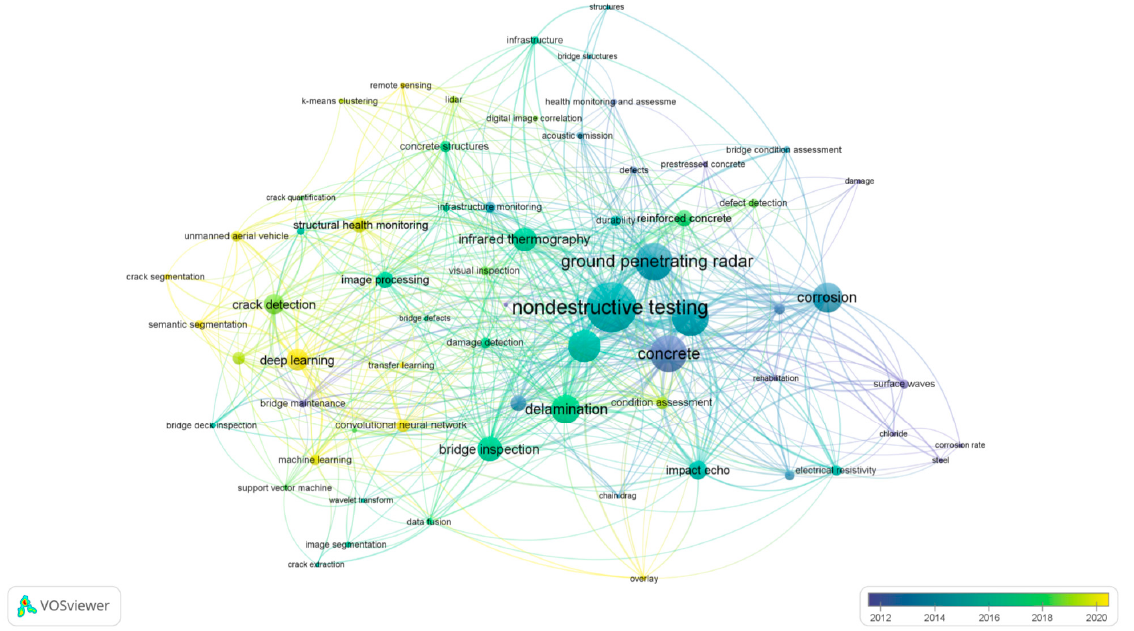
Figure 11. Temporal co-occurrence network of author keywords in the research on CBD_NDT .